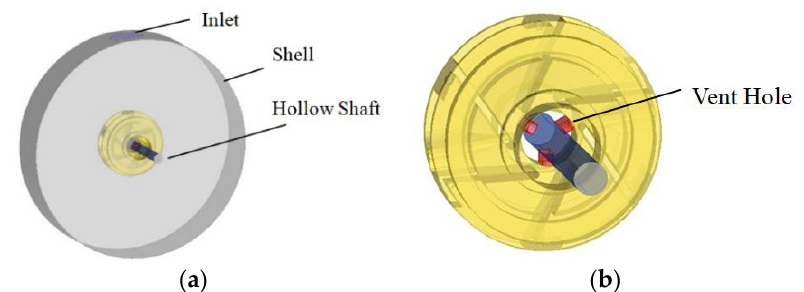
Figure 3. Physical models. ( a ) Whole structure; ( b ) partial structure.